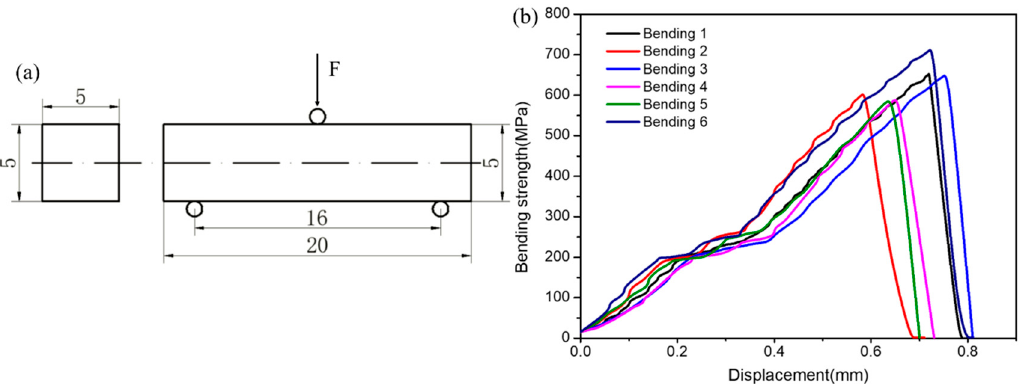
Figure 9. ( a ) Dimension of the as-SLMed Al-Si samples and ( b ) bending strength-displacement curves for the as-built samples. Table 5. Bending data for the Al-Si alloys manufactured by different methods.